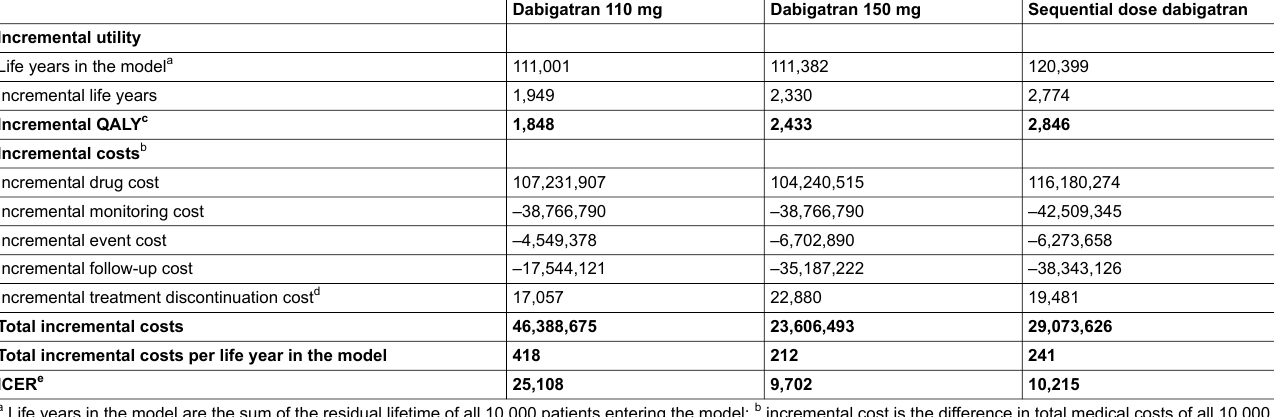
Table 6 : Incremental costs and QALY in the whole patient population. As the sequential dose scenario is modelled on a slightly different subpopulation of the RE-LY trial, the comparison of the results of the sequential dose scenario with the other two scenarios should be limited to the comparison of the ICER and should not include a comparison of the number of clinical events